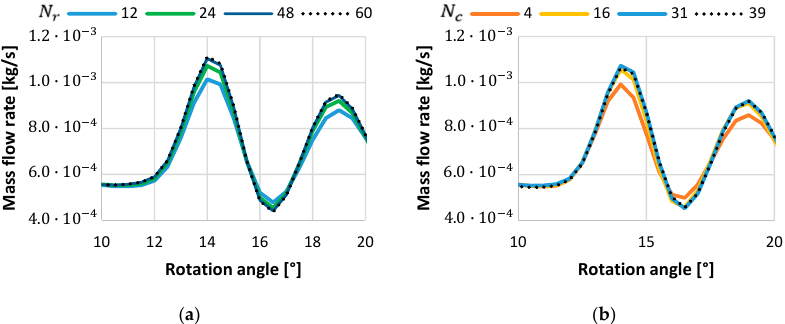
Figure 9. Influence of ( a ) N r at N c = 31 and ( b ) N c at N r = 24 on the instantaneous mass flow rate ripple at outlet 1. Energies 2020 , 13 , x FOR PEER REVIEW